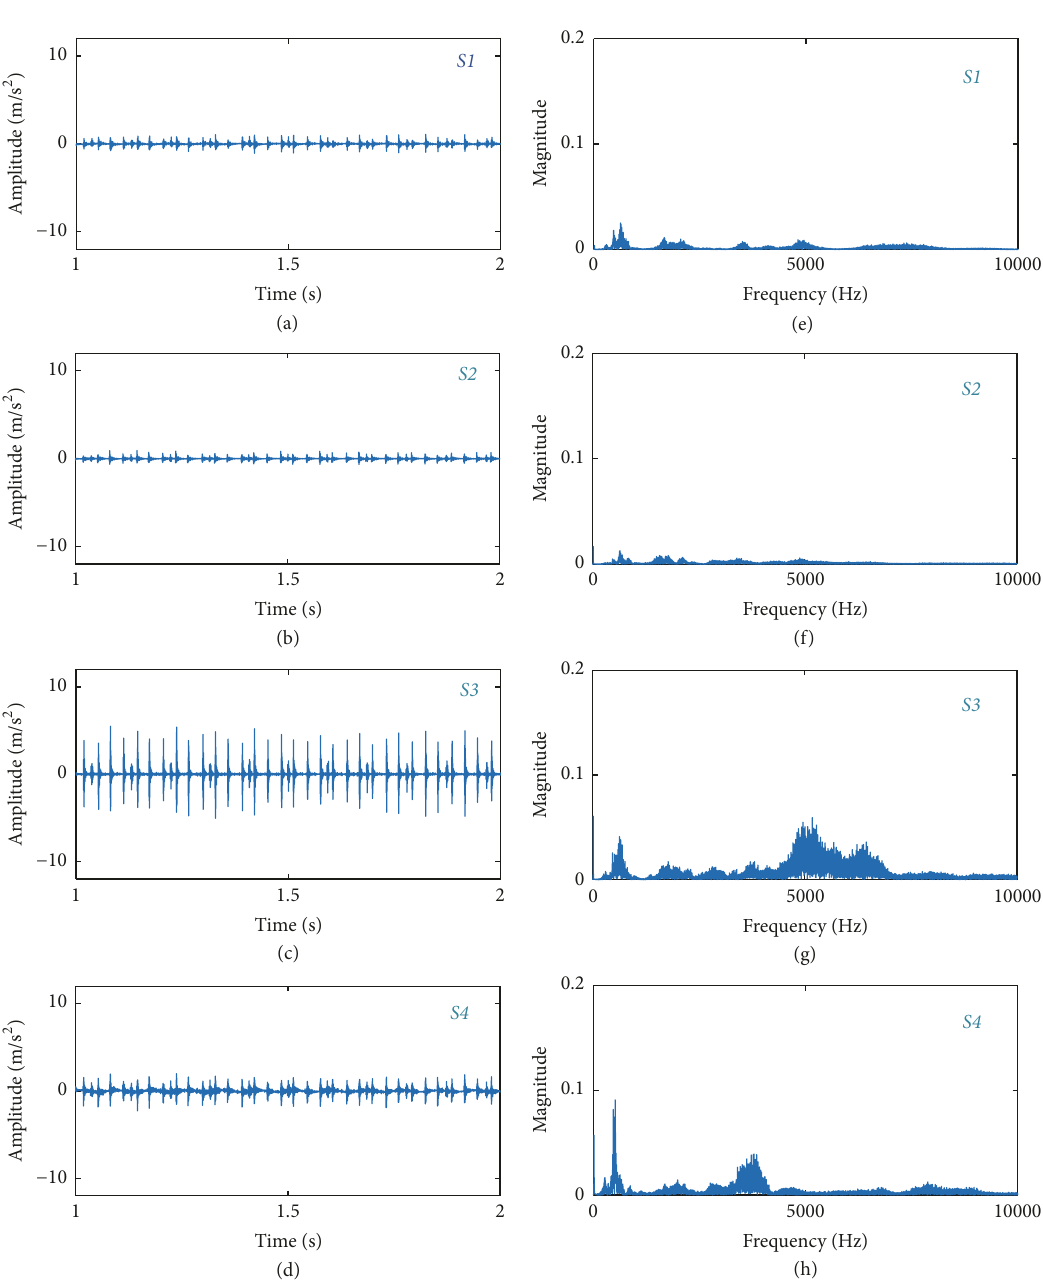
Figure10:Casestudy2:thecapturedtimedomainvibrationsignalsfromS1toS4in(a)to(d),respectively,andtheircorrespondingspectrums in (e) to